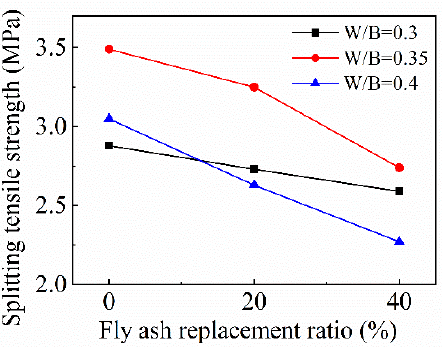
Figure 12. Variation of FRAC splitting tensile strength with fly ash replacement ratio.